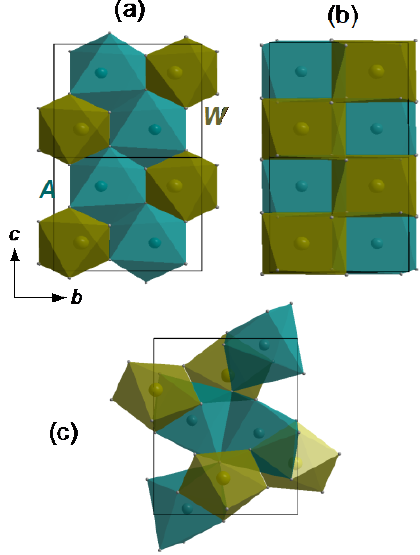
Figure 1. ( a ) General ambient-pressure wolframite-type structure of AX O 4 ( X = W) compounds and high-pressure (HP) structure of ( b ) InTaO 4 and ( c ) CdWO 4 . In ( a ), the coordination polyhedra of the divalent cation A (W) are shown in green (turquoise). In ( b ), the same color code is used for In and Ta polyhedra, respectively. In ( c ), Cd (W) polyhedra are shown in green (turquoise).